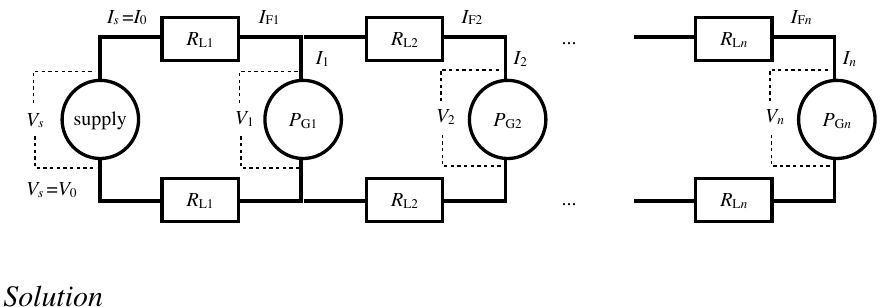
Figure 2. Flattened schematic for the daisy-chained